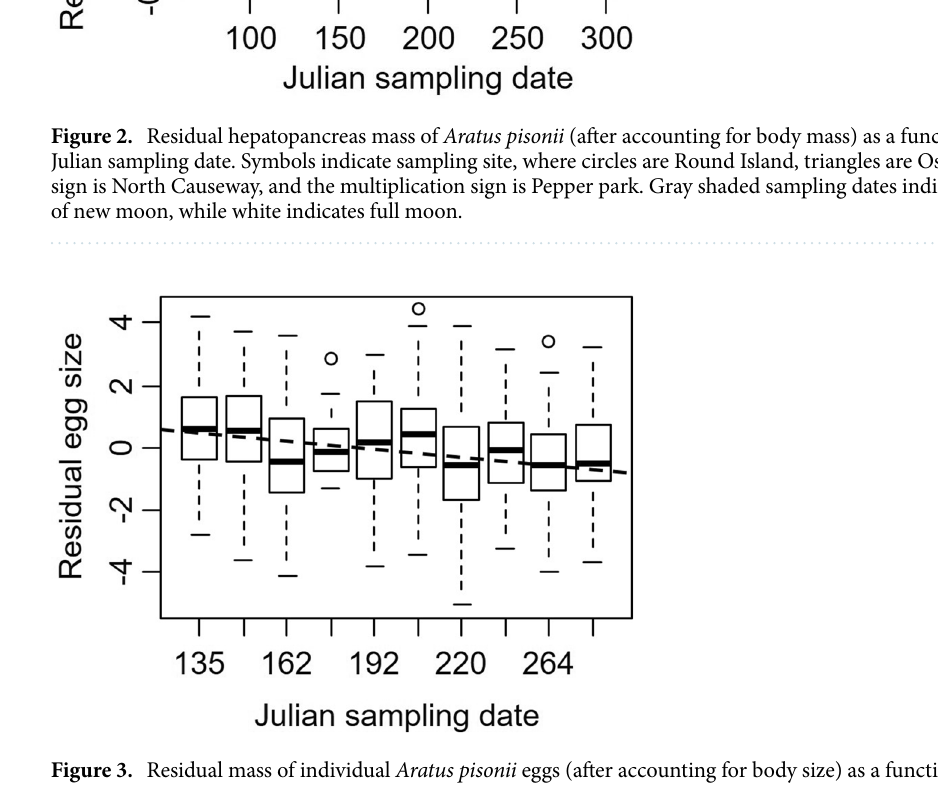
Figure 3. Residual mass of individual Aratus pisonii eggs (after accounting for body size) as a function of Julian collection date. The heavy lines of each box plot shows the median, the box encompasses the first and third quartiles of the data, whiskers encompass 95% of the data, and circles indicate outliers that fall outside of this range. The dashed line is drawn to highlight decreasing egg mass through